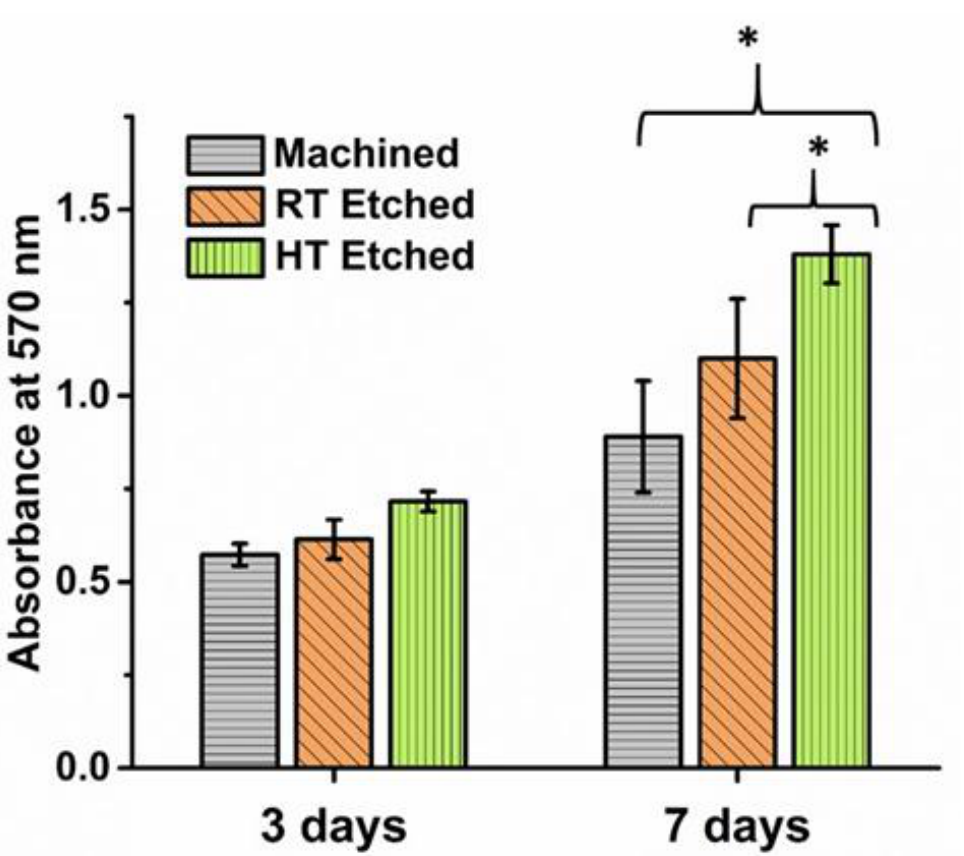
Figure 12. Bar diagram showing the cell proliferation of MG 63 cells on the control and experimental surfaces at three and seven days of cell culture by the MTT assay (* p < 0.05).